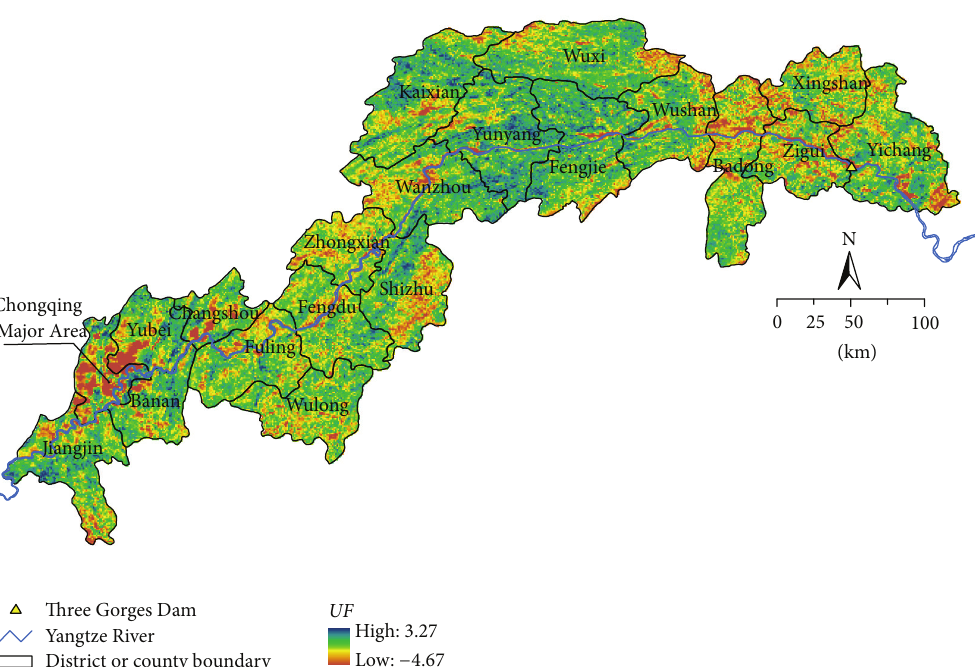
Figure 2: The Mann-Kendall trend test (absolute value of 𝑈𝐹 ) of vegetation activity in TGA.